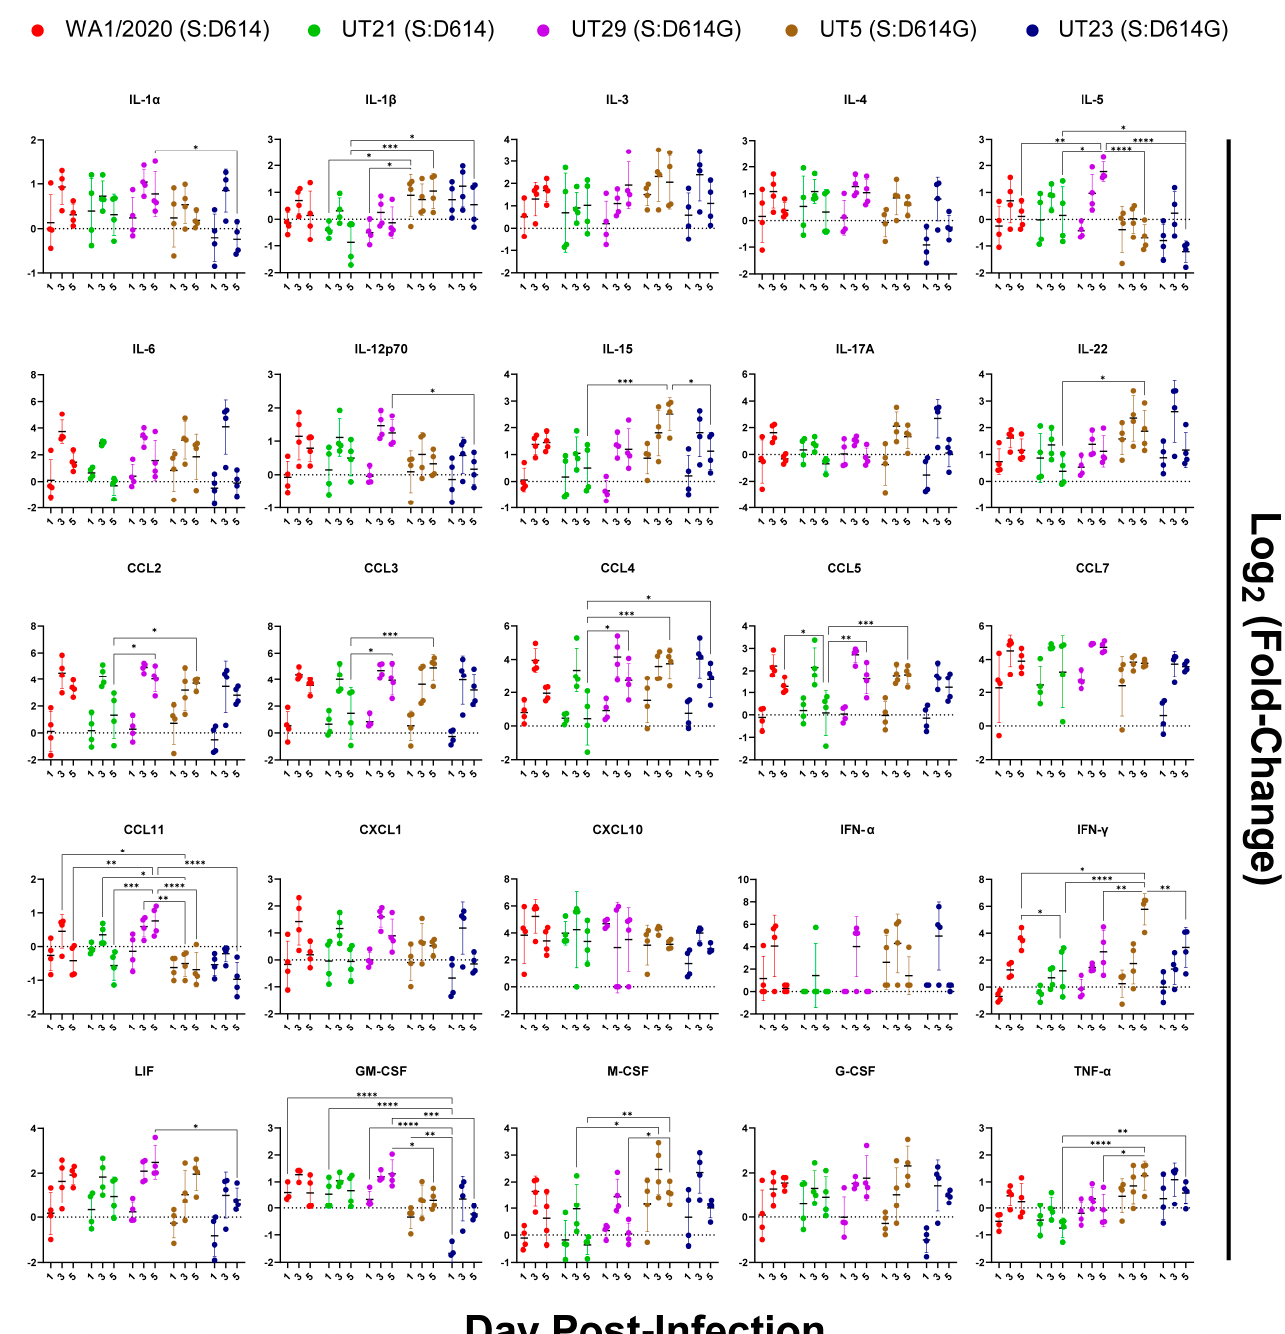
Figure 8. Immune protein response profiles of SARS-CoV-2 variants in lungs of K18-hACE2 mice (n = 4/virus per day) on days 1, 3, and 5 post-infection. Innate immune responses in lung following infection of K18-hACE2 mice with SARS-CoV-2 isolates were measured and protein concentration of each analyte were log2 (fold-change) transformed following comparison to mock. The mean and multiple comparisons at 95% confidence intervals are presented. Legend: WA1/2020 (red), UT21 (green), UT29 (violet), UT5 (brown), or UT23 (navy blue); * = p < 0.05, ** = p < 0.01, *** = p < 0.001, **** = p < 0.0001.